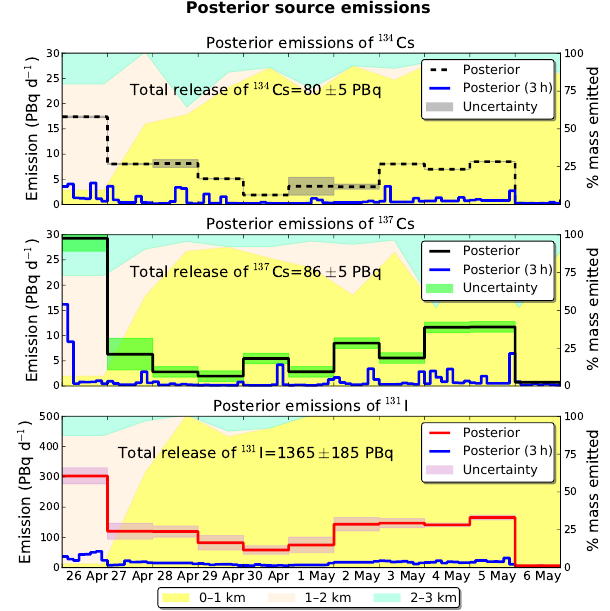
Figure 5. Daily posterior emissions of 134 Cs, 137 Cs and 131 I (red line) against uncertainty (sum of eight time steps per day) and 3- hourly posterior emissions (blue line) from 26 April to 7 May 1986. Note that emissions are plotted only until 6 May for simplicity, as they were close to zero during 7 May 1986. On the right axis the vertical distribution of the emissions at altitudes 0–1km (yellow), 1–2km (beige) and 2–3km (turquoise) is plotted as shaded back- ground